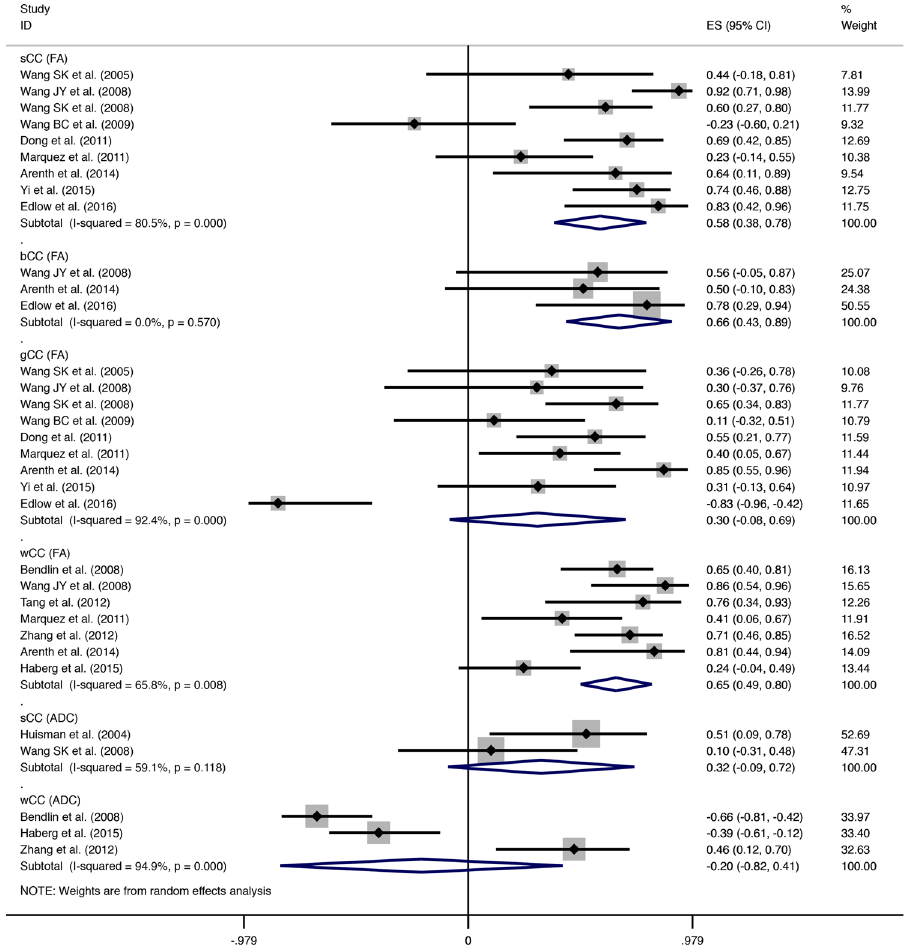
Figure 6. Subgroup analysis according to subareas within the CC from ROI studies. Solid-line diamonds represent overall r value of FA-consciousness correlations, and dotted diamonds are for ADC-consciousness correlations. FA, fractional anisotropy; ADC, apparent diffusion coefficient; CI, confidence interval; sCC, splenium of corpus callosum; bCC, body of corpus callosum; gCC, genu of corpus callosum; wCC, whole corpus